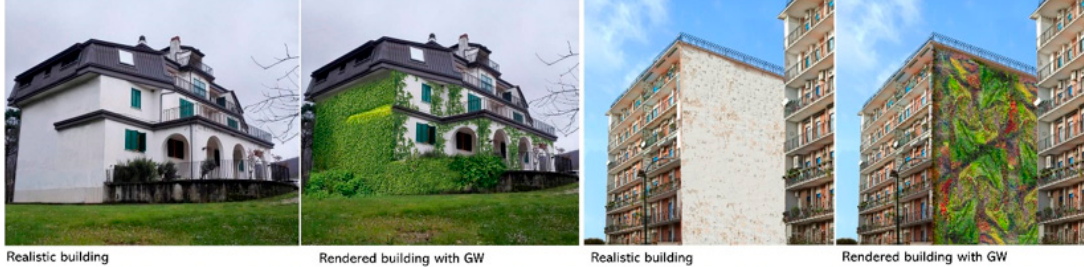
Figure 4. Examples of applications of GW , spontaneously or in façade retrofit.